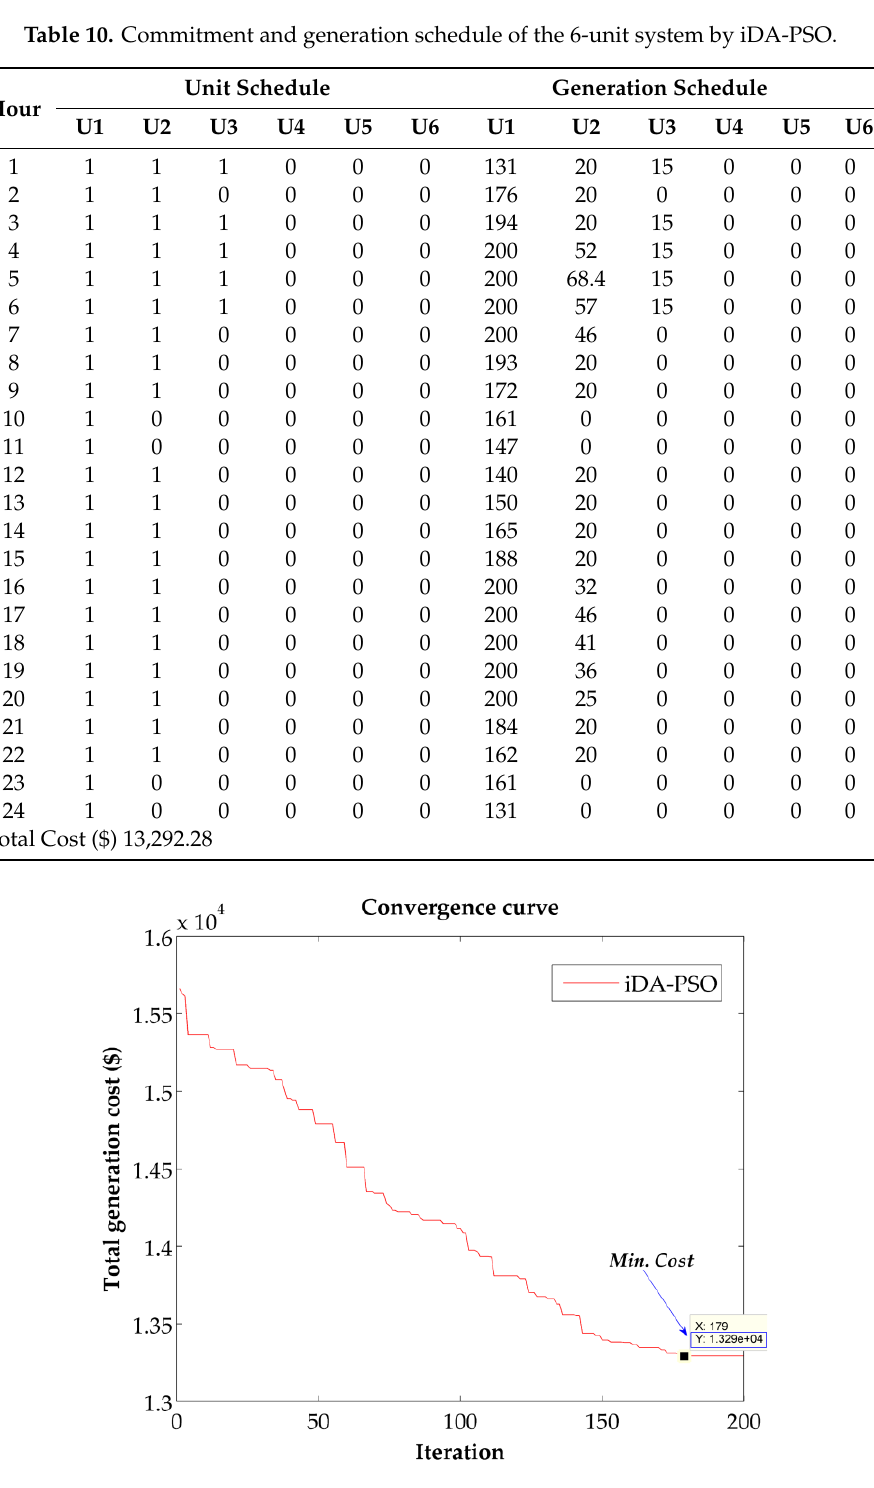
Figure 3. Convergence curve of the iDA-PSO approach for the 6-unit system .